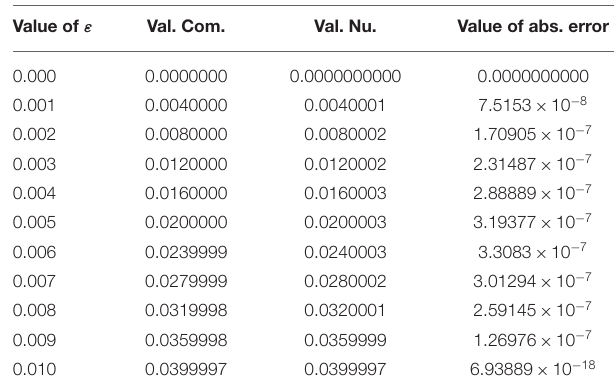
TABLE 1 | Computational, semi-analytical, and absolute error values obtained by using the Adomian decomposition method. Value of ε